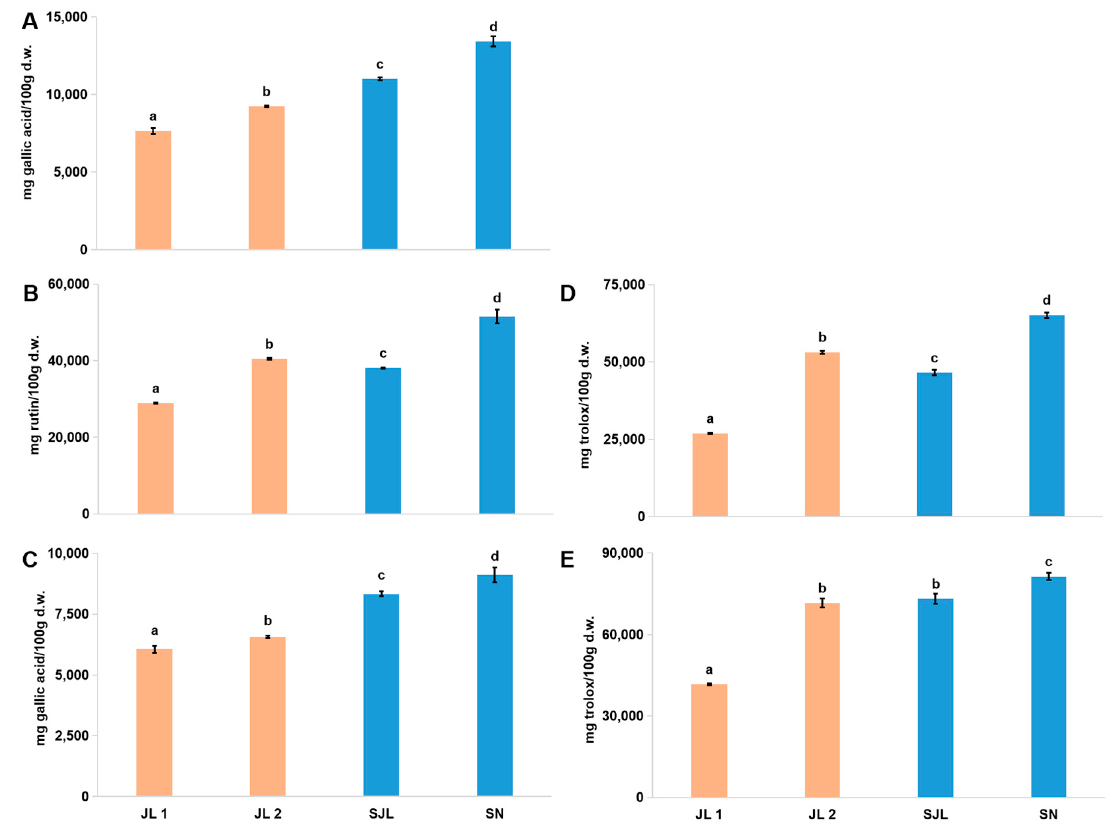
Figure 1. Characteristics of the phenolic components and antioxidant abilities of Rhodiola (JL1, JL2, SJL, and SN). ( A ): Total phenols; ( B ): Total flavonoids; ( C ): Total tannins; ( D ): DPPH antioxidant ability; ( E ): ABTS antioxidant ability. Gallic acid was used as a standard for the total phenols and total tannins. Rutin was used as a standard for the total flavonoids. Trolox was used as a standard for the DPPH and ABTS antioxidant abilities. Results are presented as the mean ± SD of three independent experiments ( n = 3) and are expressed as mg standard per 100 g d.w. of plant material. In each column, di ff erent letters (a, b, c, d) mean significant di ff erences between two groups ( p < 0.05) found via a T-test. Note: Rhodiola samples are presented according to the ascending order of altitude from left to right.